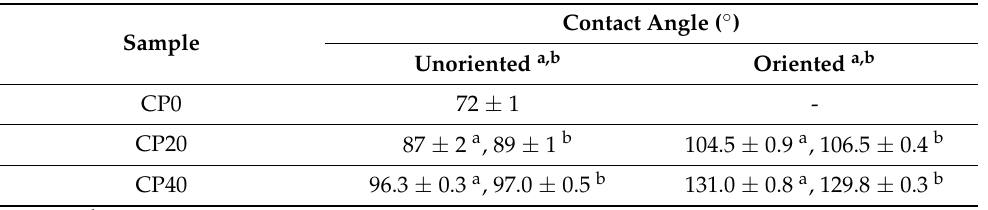
Table 2. Water contact angle values of unmodified Poly(epichlorohydrin-co-ethylene oxide) (CP0), CP20, and CP40